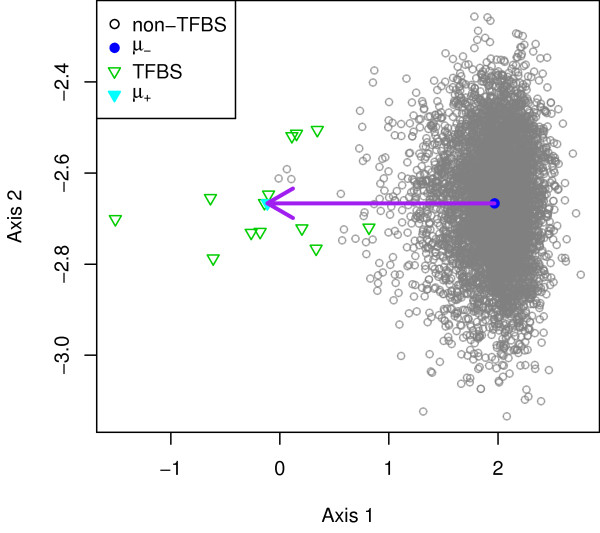
Illustration of the NPV method. The solid arrow represents the negative-to-positive vector μ+−μ−, pointing from μ−to μ+. The hallow triangles denote the known binding sites, whereas the circles represent the known non-binding sites. The center of the binding site vectors is marked by the solid triangle, while the center of the non-binding site vectors is marked by the solid circle.